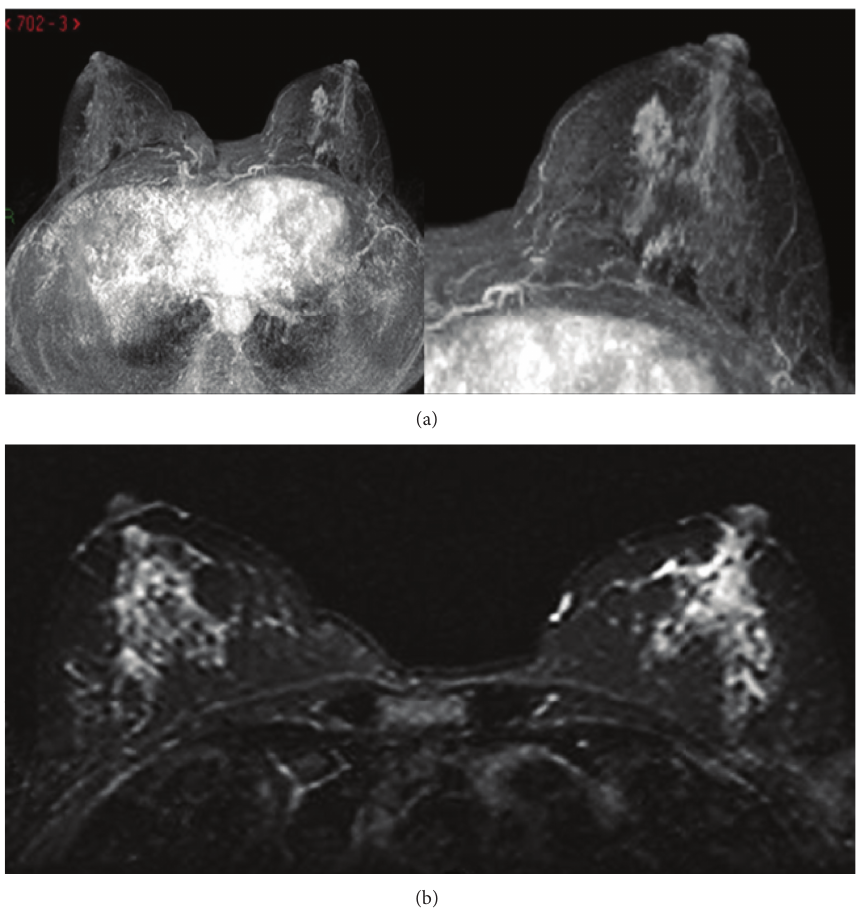
Figure 3: T1 weighted high-resolution isotropic volume examination (THRIVE) (a) and T2 weighted short tau inversion recovery (STIR) sequences (b) show contrast enhancement of the left nipple extending to subareolar